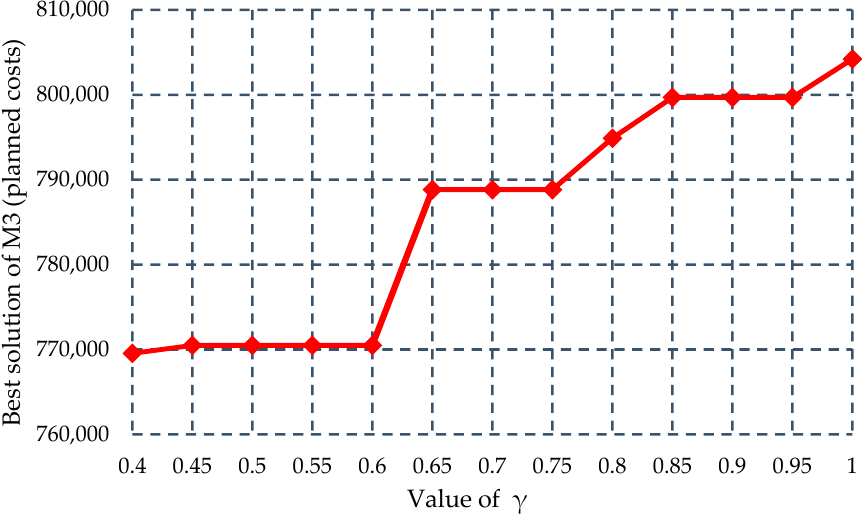
Figure 6. Sensitivity of the best solution with respect to the value of γ .